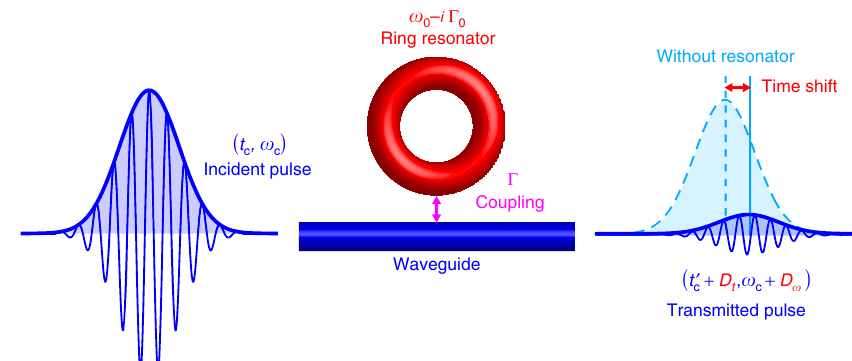
Figure 1 | Time and frequency shifts of an optical pulse interacting with a waveguide-coupled resonator. An incident Gaussian wave packet with central frequency o c and intensity-maximum time t c in the starting point propagates through a waveguide with a side-coupled ring resonator. The resonator is characterized by a resonant frequency o 0 , dissipation rate G 0 , whereas the coupling rate between the resonator and the waveguide is denoted by G . In the absence of the resonator, the intensity of the transmitted pulse is expected to be maximum at the time t 0 in the point of observation. Interacting with the c resonator, the transmitted pulse experiences shifts in both its arrival time (with time delay D t , shown negative here) and its central frequency (frequency shift D o ). These shifts are strongly enhanced near the critical-coupling (zero-scattering) regime, when most of the pulse energy is absorbed by the resonator and the transmitted-pulse amplitude is